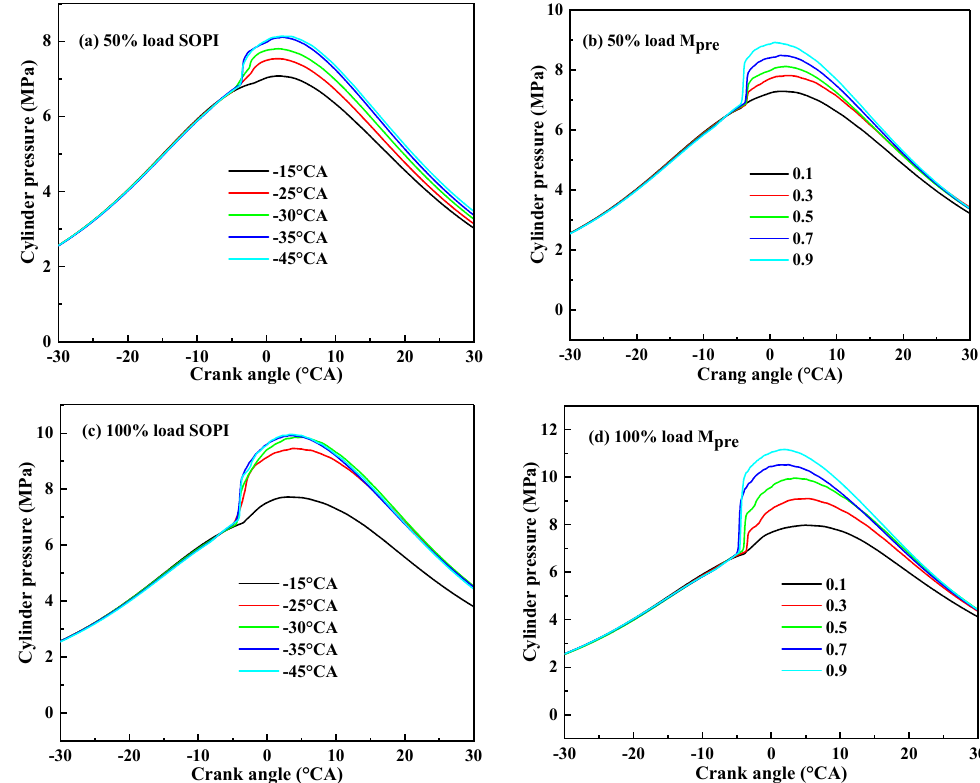
Figure 7. Comparisons of cylinder pressure under different load conditions.